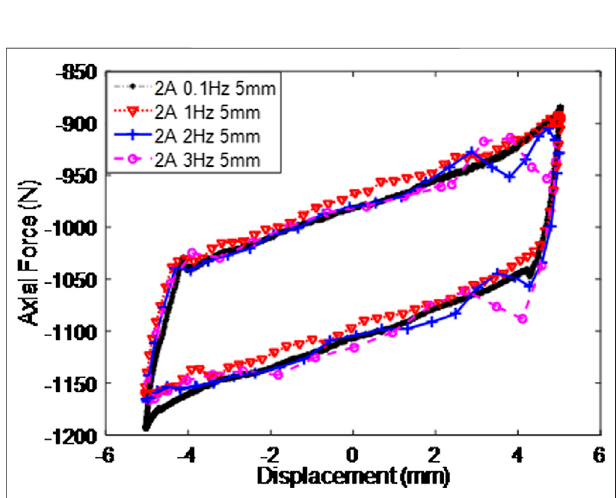
FIGURE 7 | Force-displacement loops with 2 A current applied under different